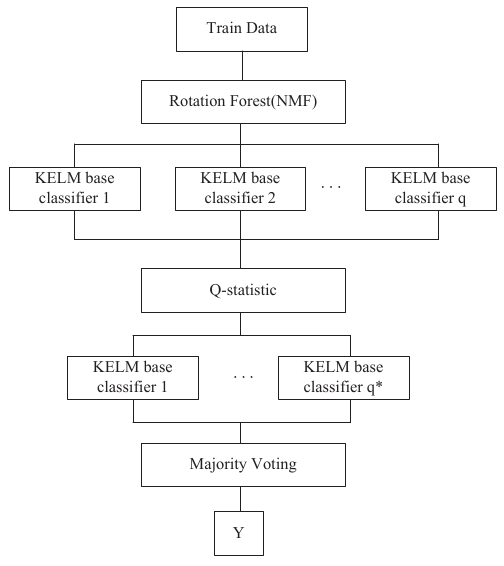
Figure 2. The structure of